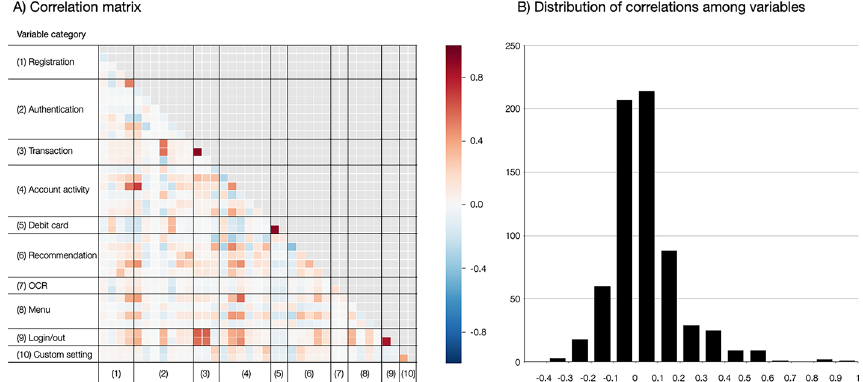
Fig. 1 Correlation coefficients among features selected in the first stage models ( A ) and distribution of correlation values ( B ). The list of variables in the correlation matrix (A) is in the order of the variable names arranged in Table